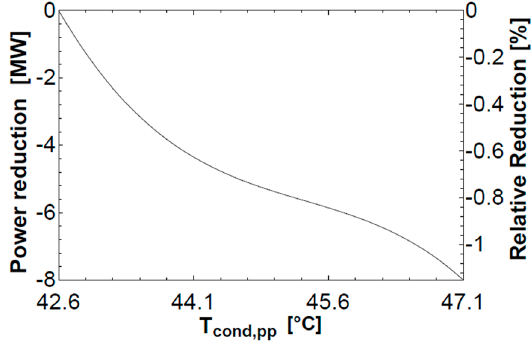
Figure 12. Relative reduction in power plant output with increasing condensing temperature from a baseline temperature of 42.2 °C.